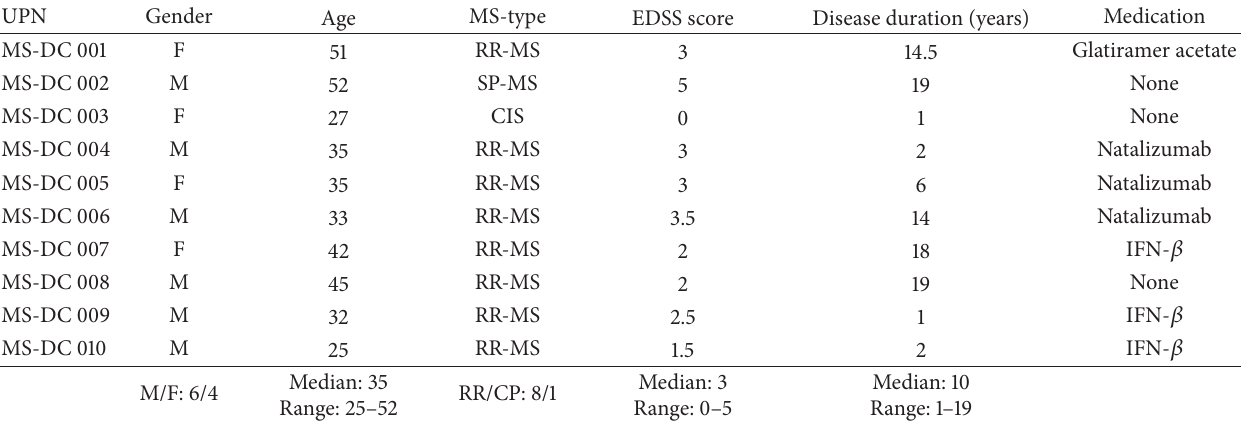
Table 1: Clinical details of the patients recruited into the